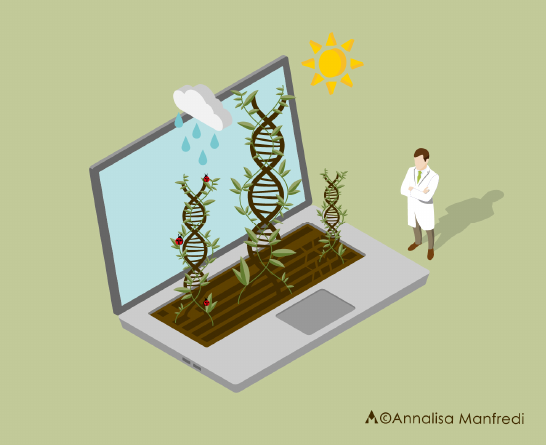
Figure 2. A new figure of breeder is beginning to thrive in the niche created by biotechnological and digital revolution. By combining expertise in complementary areas (open-field trials, wet-lab techniques, big data analysis, and interpretation), they will have the greatest potential to be successful in developing climate-resilient crops.